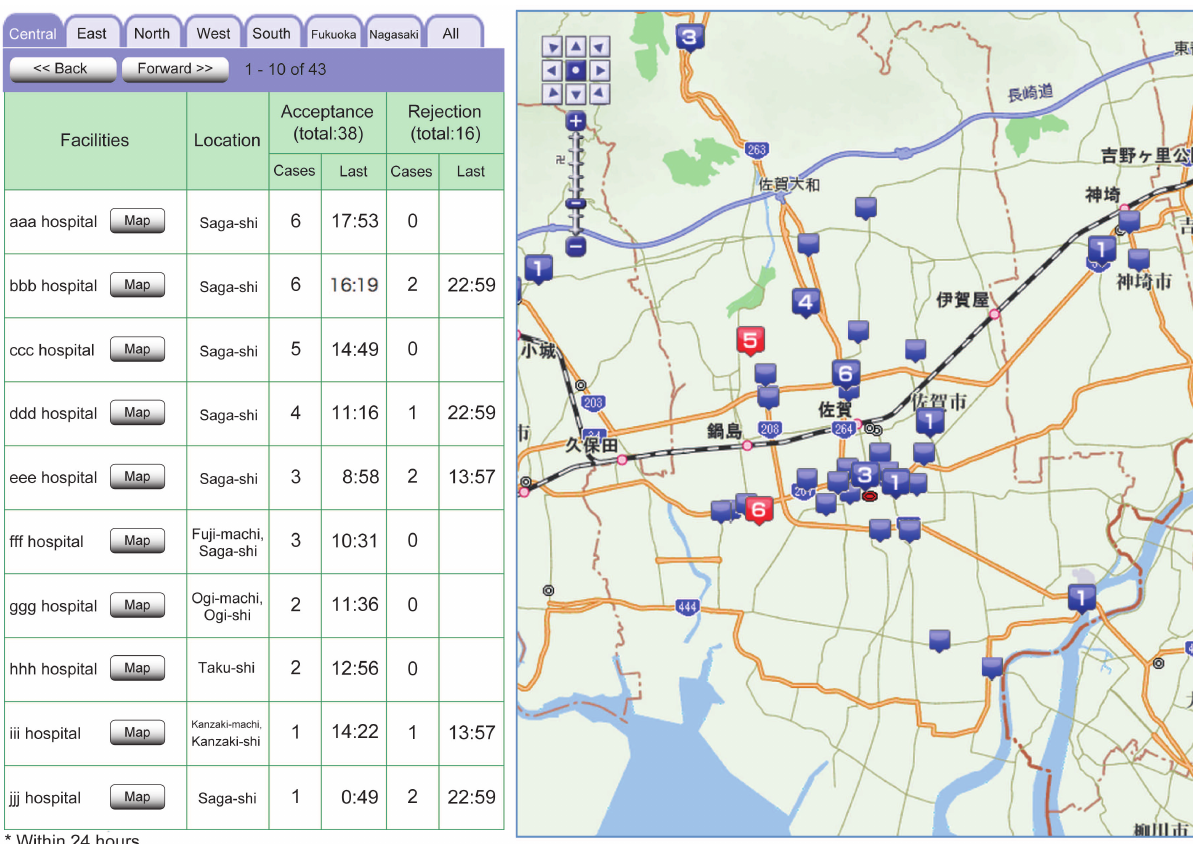
Figure 4. Real-time monitoring page with a